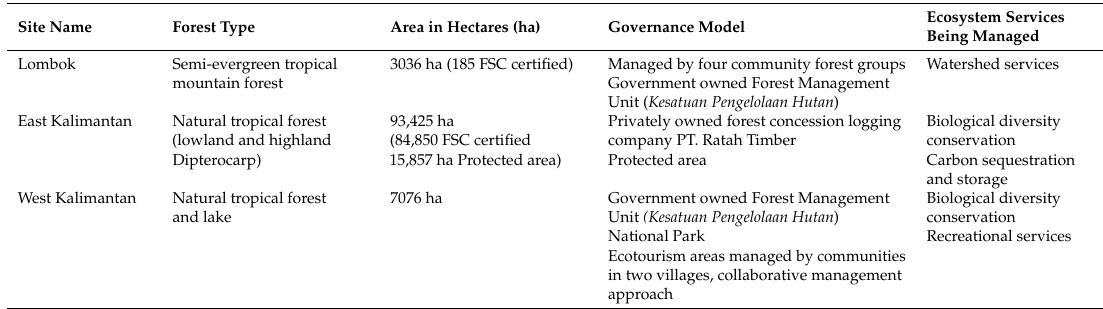
Table 2. Forest Certification for Ecosystem Services (ForCES) Forest Stewardship Council (FSC) Certification project pilot sites